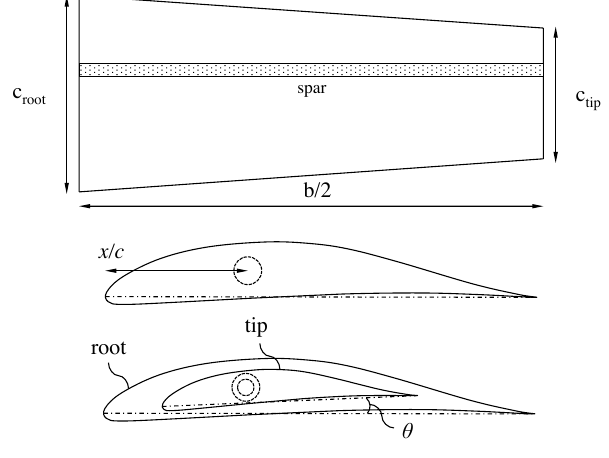
Figure 14. Parameterized wing